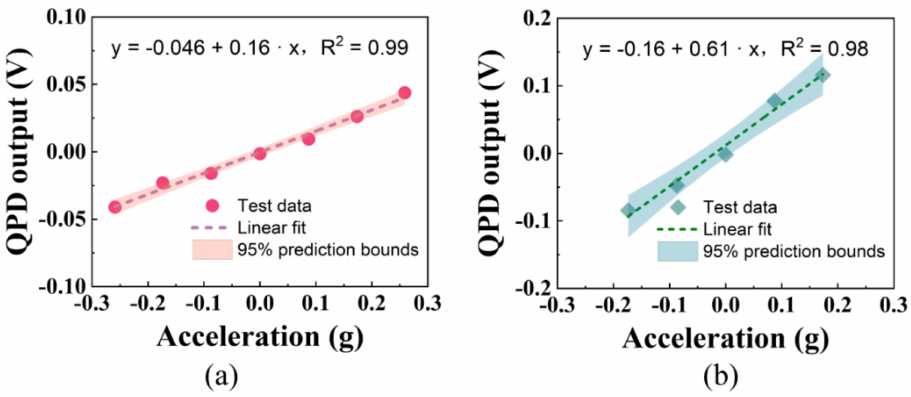
Figure 11. The fitting curve of the acceleration response along ( a ) the short axis from − 15 ◦ to 15 ◦ and ( b ) the long axis from − 10 ◦ to 10 ◦ of the elliptical